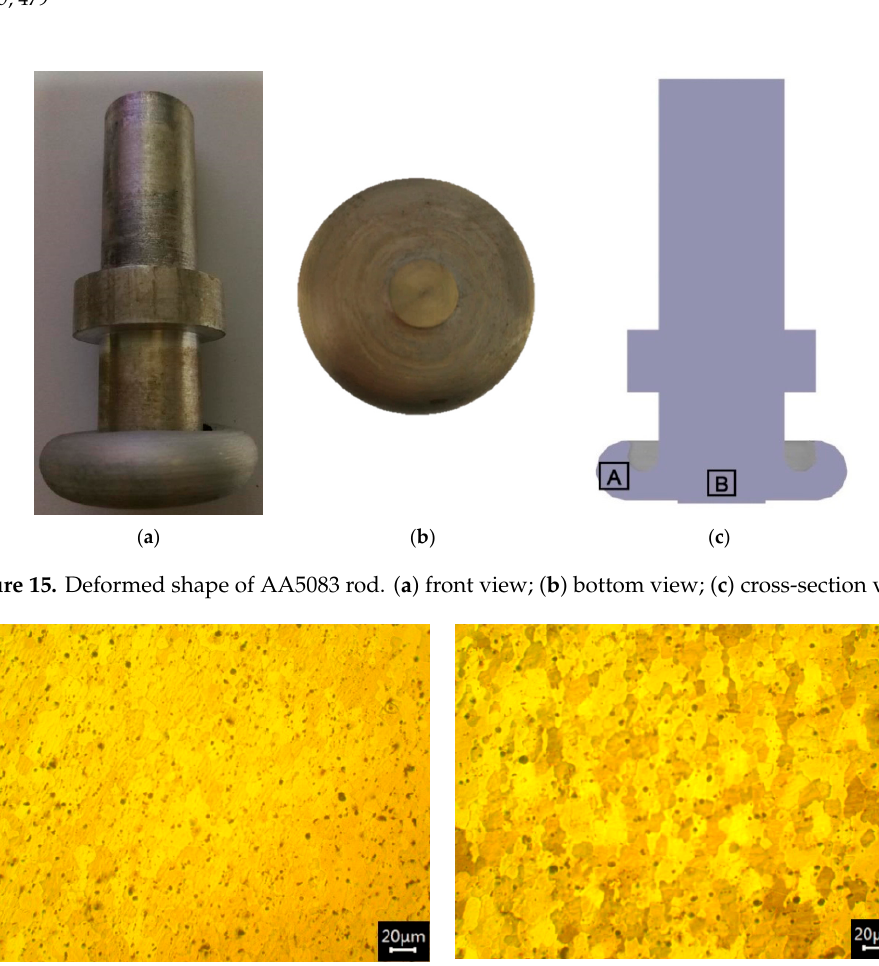
Figure 16. Rod microstructure in ( a ) region A and ( b ) region B.